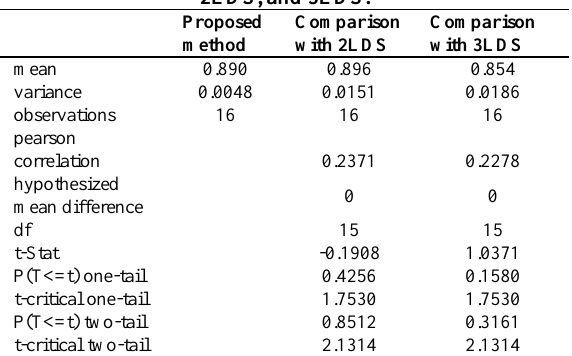
Table 9. T-test comparison of the proposed method with 2LDS, and 3LDS. Proposed